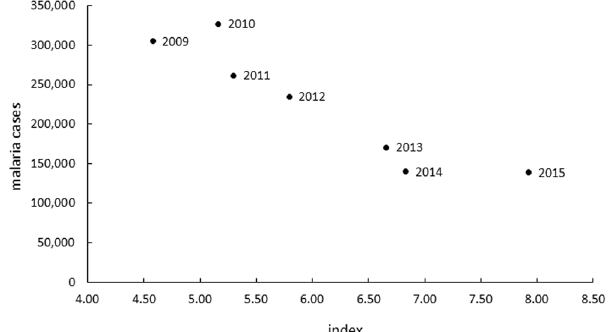
Figure 5. Graph of the dispersion between the total number of malaria cases and the economic index (value produced (m³)/production (m³) * 100) between 2009–2015 in Brazilian Amazonian States.